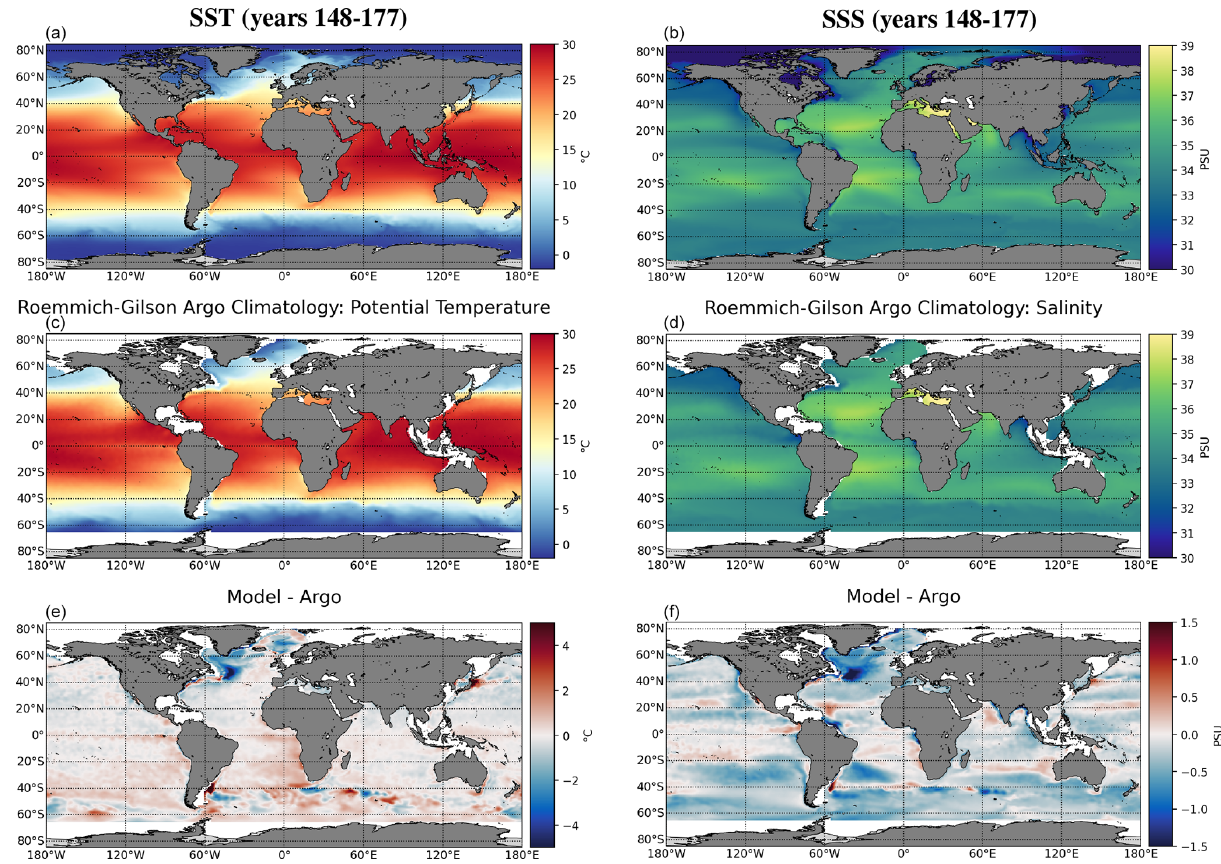
Figure 3. SST (a, c, e) and SSS (b, d, f) from the E3SM-Arctic-OSI simulation (a, b) and the Roemmich–Gilson Argo climatological data set (c, d) . The corresponding model minus observation bias is shown in panels (e) and (f) . Model climatologies are computed over years 148–177 (last 30 years of the third JRA